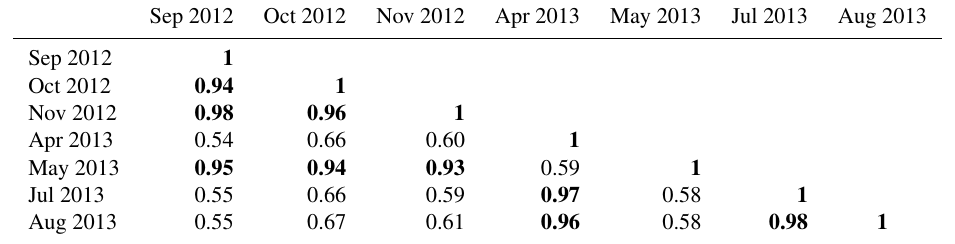
Table 2. Spearman rank correlation coefficients ( r s ) between spatial patterns of ECa e . Values of r s ≥ 0.9 are highlighted in bold.